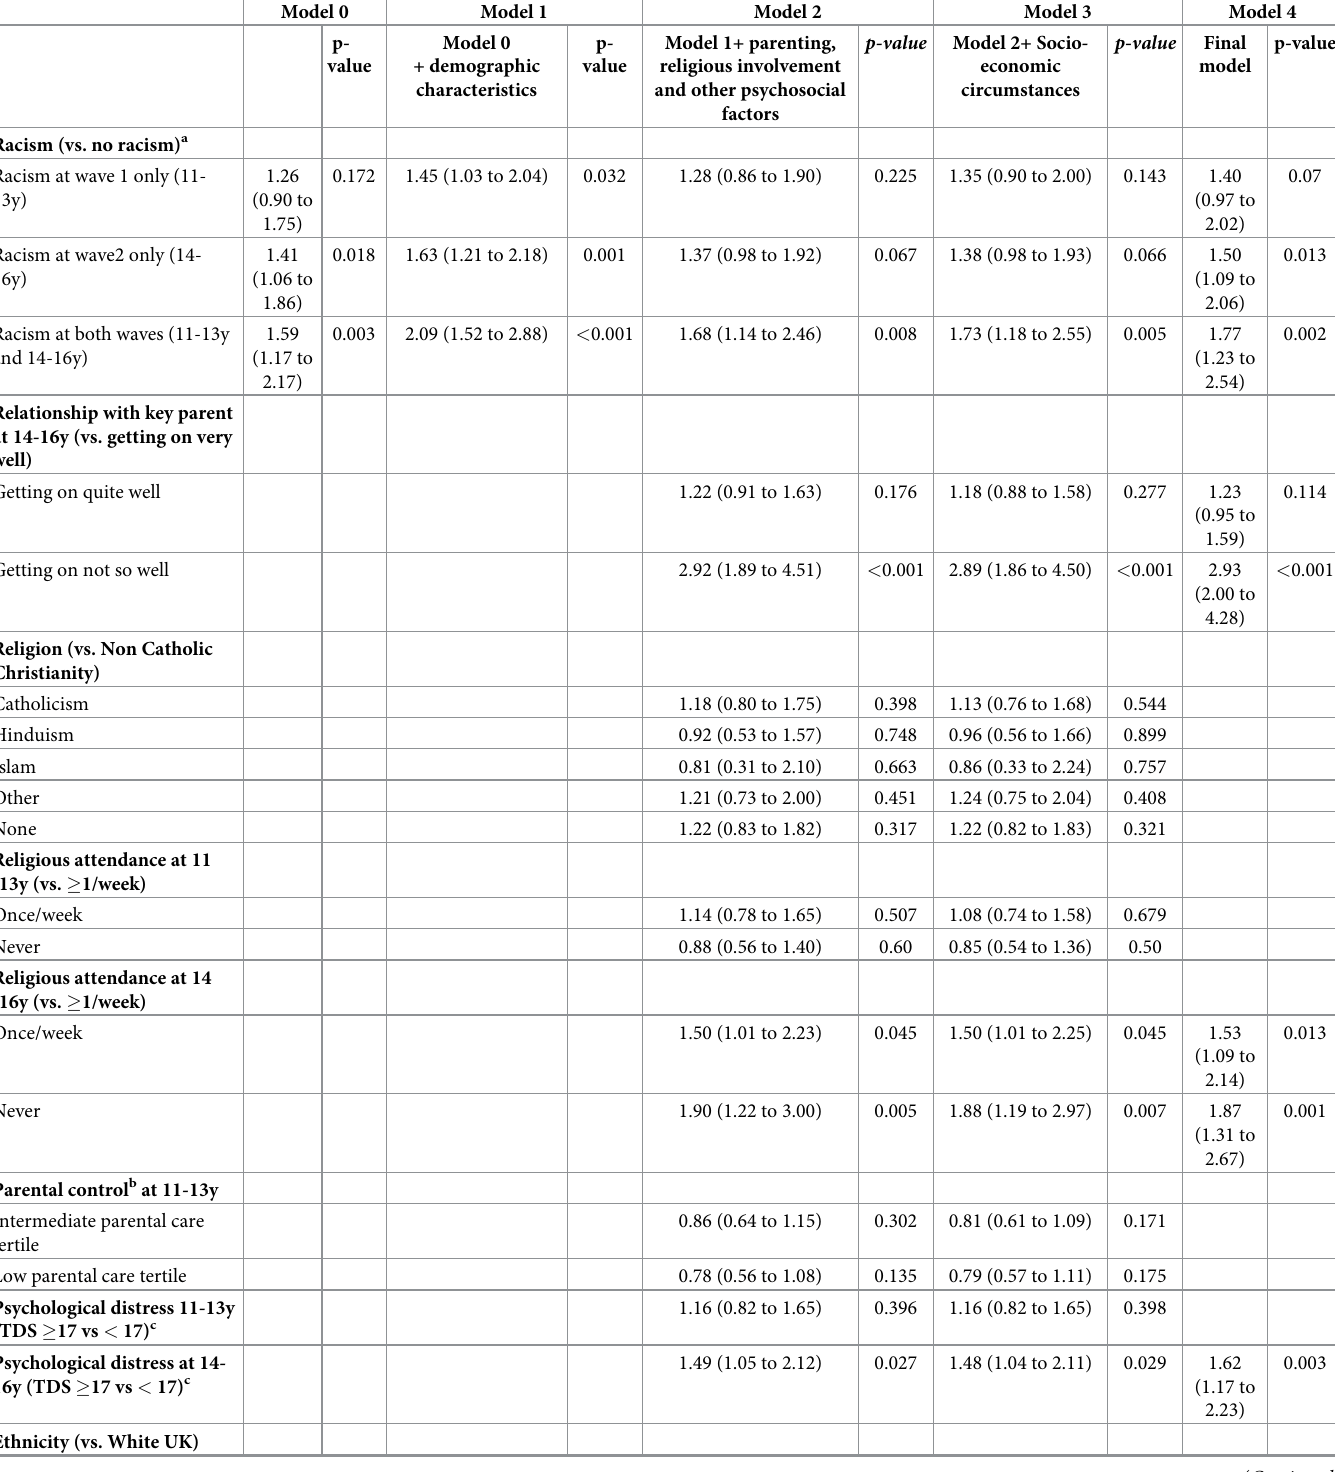
Table 5. Smoking initiation at 14-16y: The influence of racism, ethnicity, parenting and religious involvement, socio-economic circumstances: Odds ratio (95% con- fidence interval). The Determinants of Adolescent (now adult) Social well-being and Health